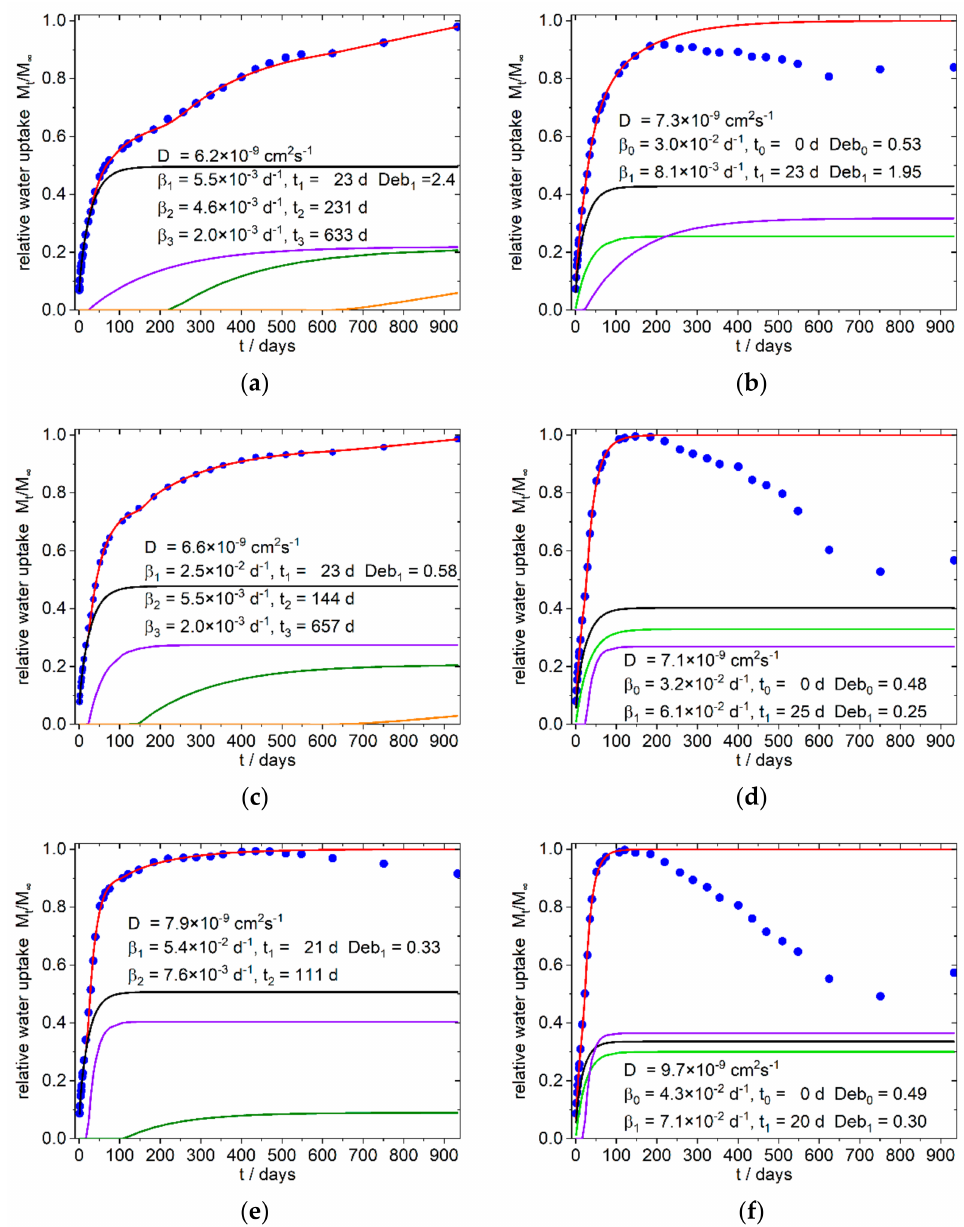
Figure 7. Simulation of water uptake of the 9:1-f/c-X Composites with X = 8.3 ( a , b ), 16.7 ( c , d ), 25 ( e , f ); mass loss in ( b , d , f ) are presumably due to extracted hemicelluloses and soluble low molecular weight carbohydrates from the SBP particles. Blue dots: experimental normalized values, red line: simulation, black line: diffusion part of water uptake, green line: part of water uptake from the relaxation process with starts with t = 0, purple and olive line: part of water uptake from the relaxation processes 1 and 2, orange line part of water uptake from the exponential growth of water